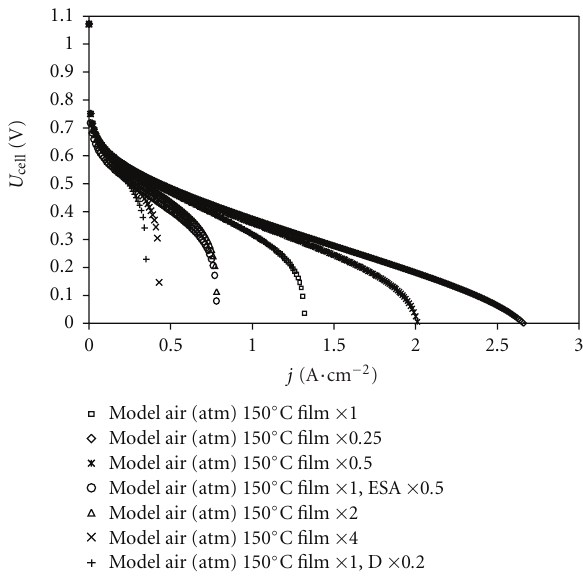
Figure 7: The e ff ect of cathode film thickness and electrolyte type/content on cell performance utilising 50% Pt/C at the cathode and 20% Pt/C on the anode at temperature of 150 ◦ C using air; alpha value of 0.75 and γ = 1 . 375 was used for the